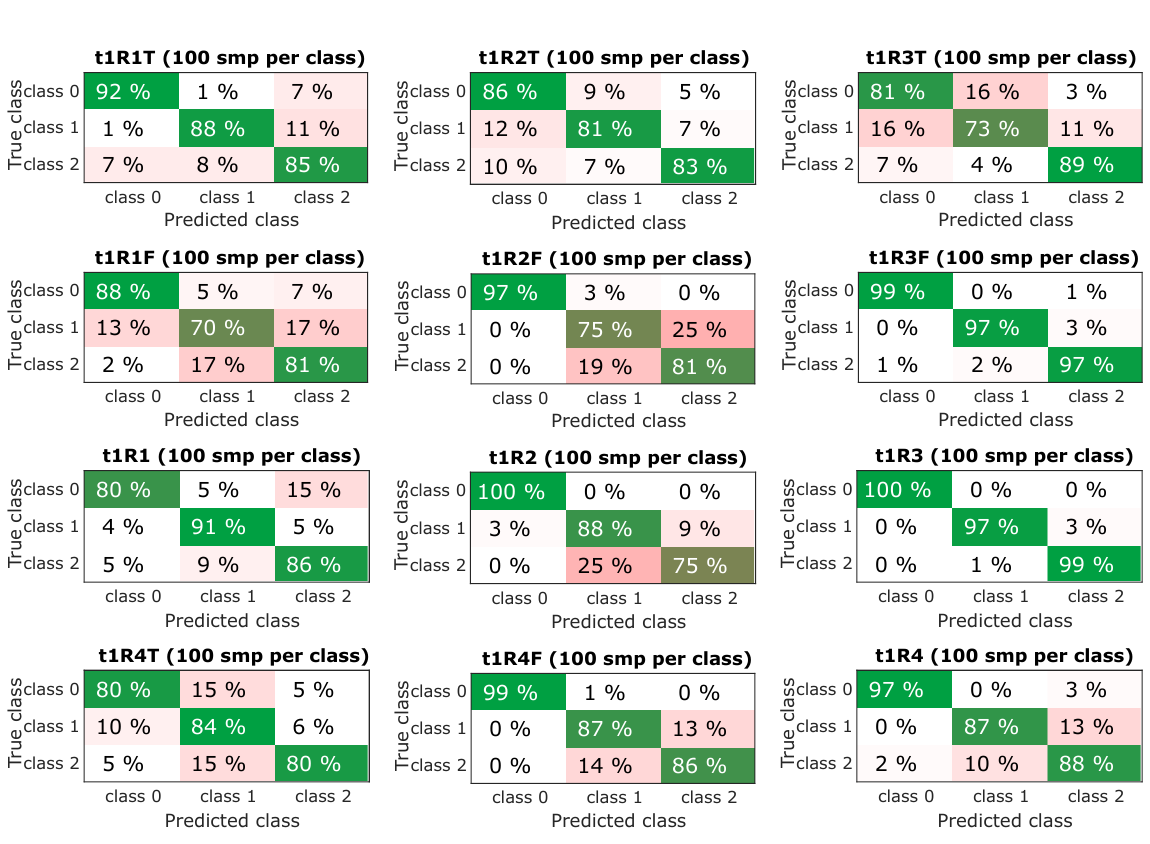
Figure 10. Resulting confusion matrix for experiments with sample time t1 (0.25 s).